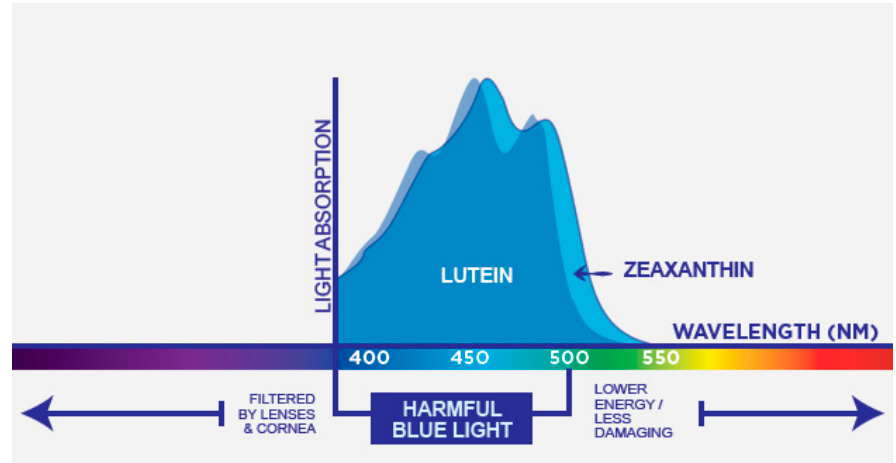
Figure 5. Absorption spectrum of lutein (blue) and zeaxanthin (light blue).